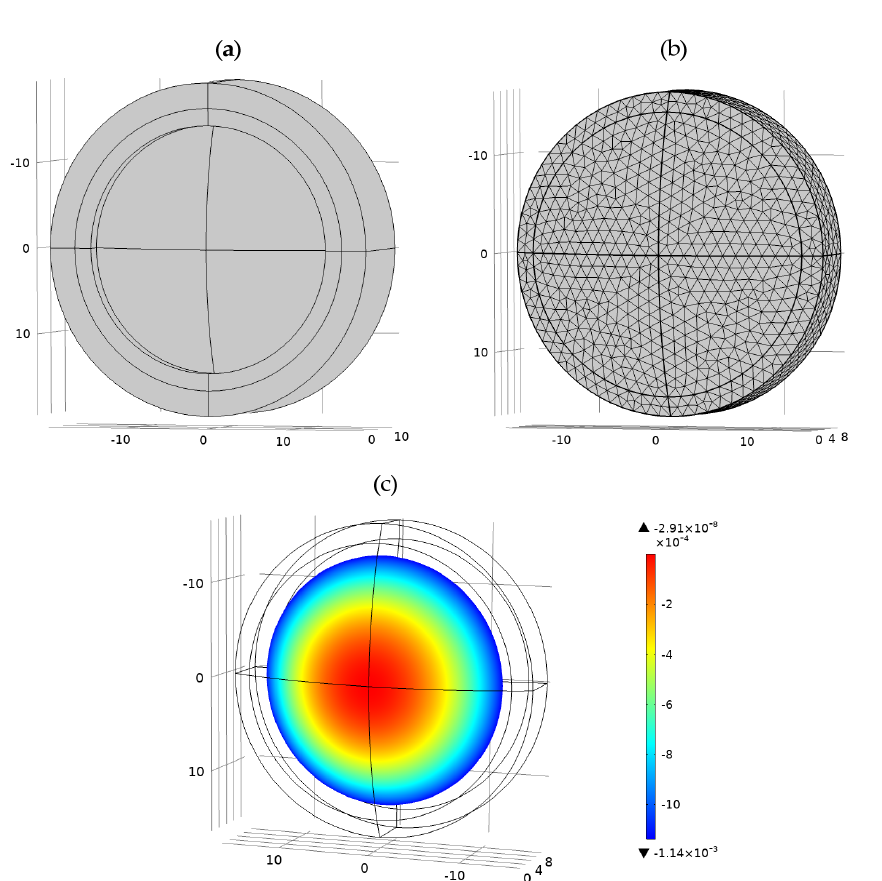
Figure 11. Parametric FEA progress: ( a ) parametric modeling; ( b ) meshing; ( c ) surface displacement cloud map.